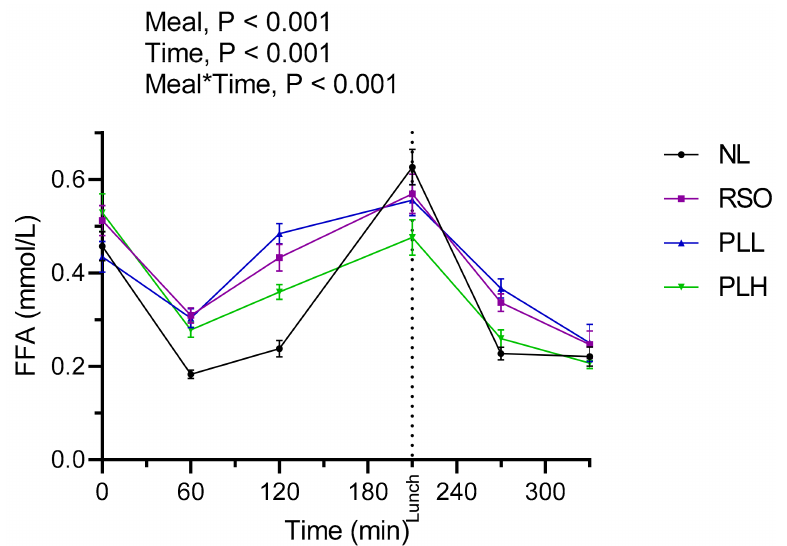
Figure 5. Concentrations of serum free fatty acid (FFAs) after breakfast and a standardized lunch meal. Values are means ± SEM, n = 20 healthy subjects. Repeated measures; mixed model in SAS. NL, oat preparation without added lipids; RSO, oat preparation added with rapeseed oil; PLL, oat preparation with a low concentration of polar lipids; PLH, oat preparation with a high concentration of polar lipids.